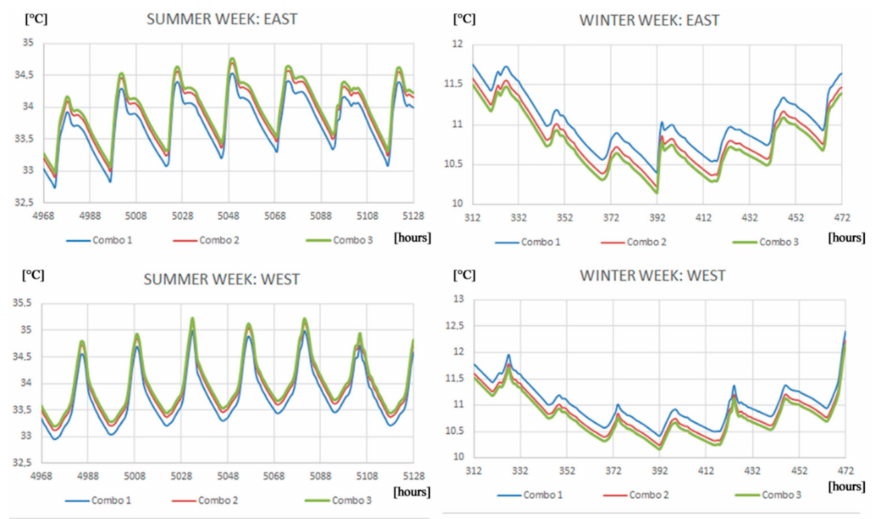
Figure 4. TOP trend for Combo 1, 2, and 3 (27 July–2 August; 14–20